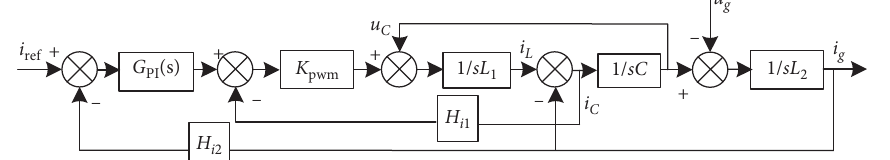
Figure 2: Block diagram of the control system of the single-phase grid-connected